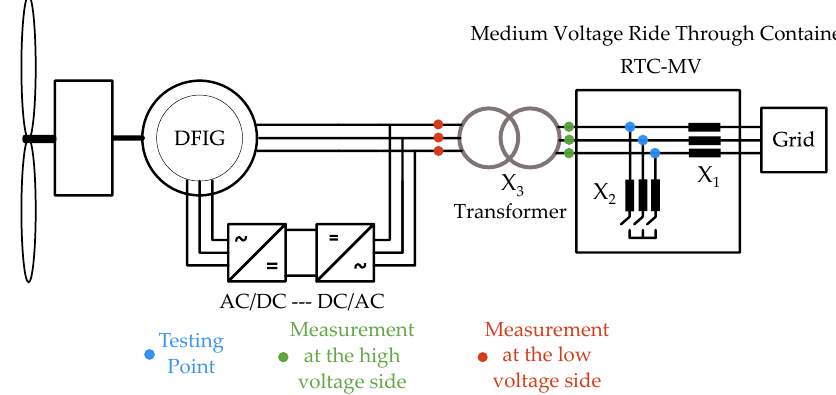
Figure 2. Voltage dip generator mobile test unit connected to the doubly fed induction generator (DFIG)